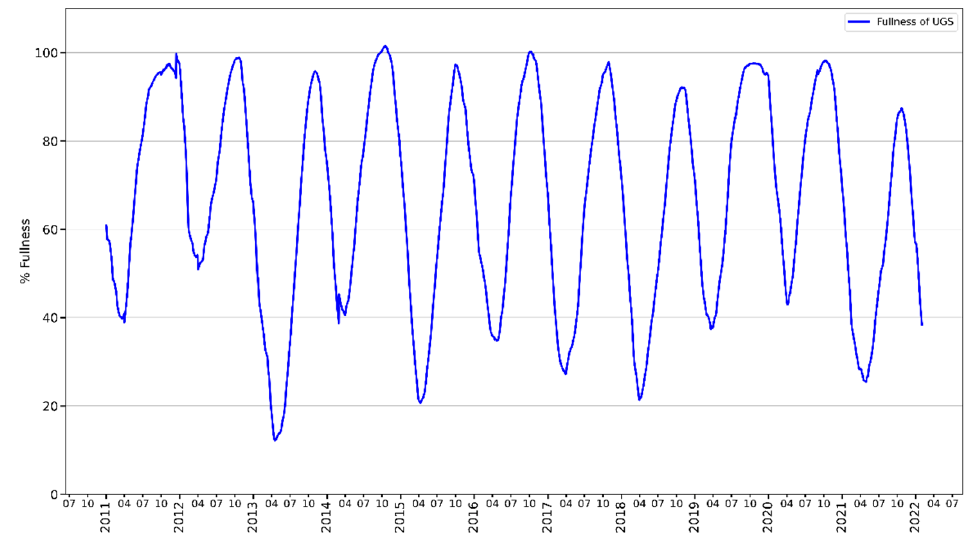
Figure 6. Chart of UGS fullness in the Czech Republic (data obtained from [48] and used with kind permission of Gas Infrastructure Europe (GIE) AGSI+ Storage Transparency Platform (https://agsi.gie.eu/#/ (accessed on 2 May 2022))).